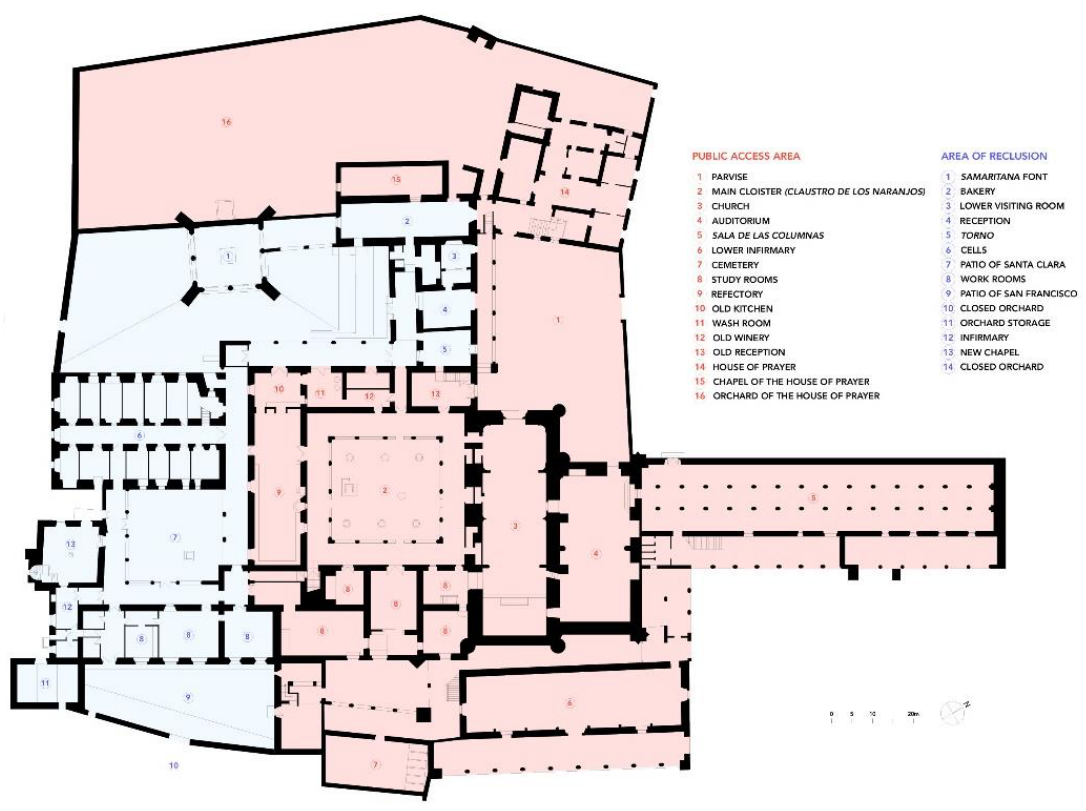
Figure 5. Monastery plan segregated by uses, 2021.